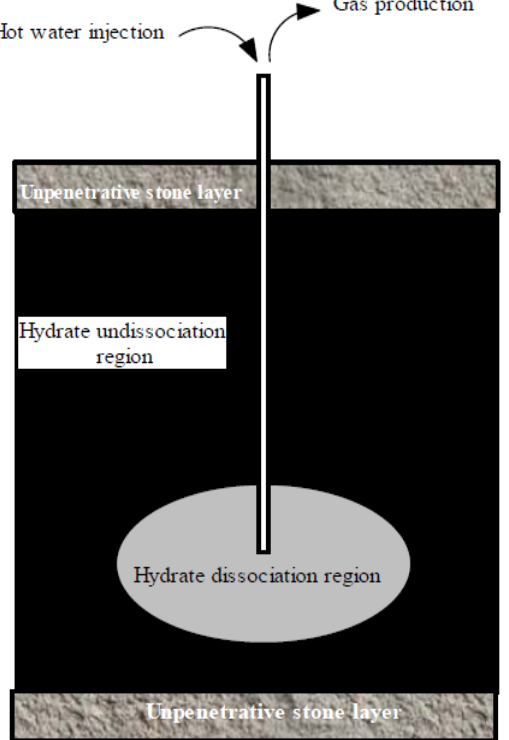
Figure 5. Gas production from hydrates by the thermal stimulation